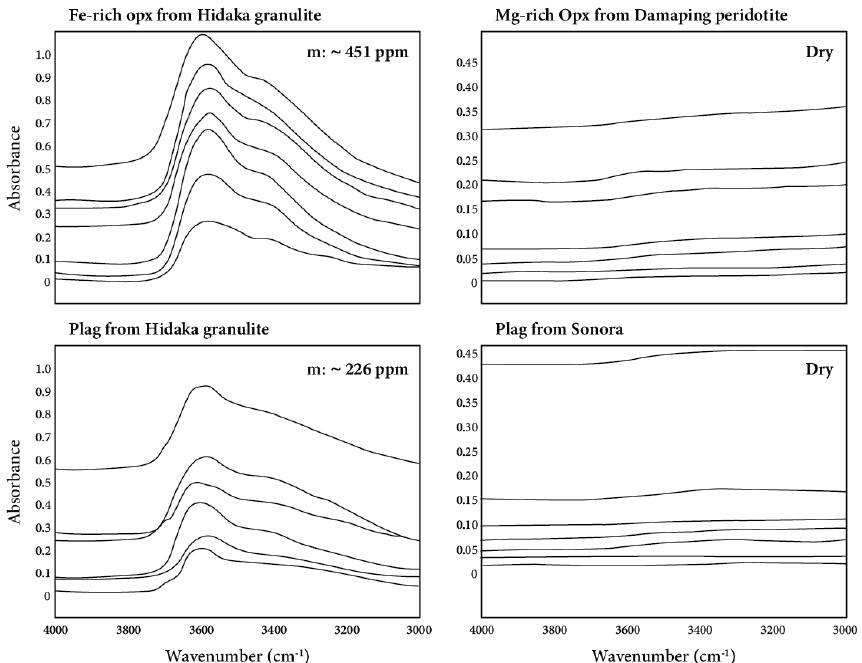
Figure 9. Representative Fourier transform infrared (FTIR) spectra of orthopyroxene and plagioclase starting materials. m: average water